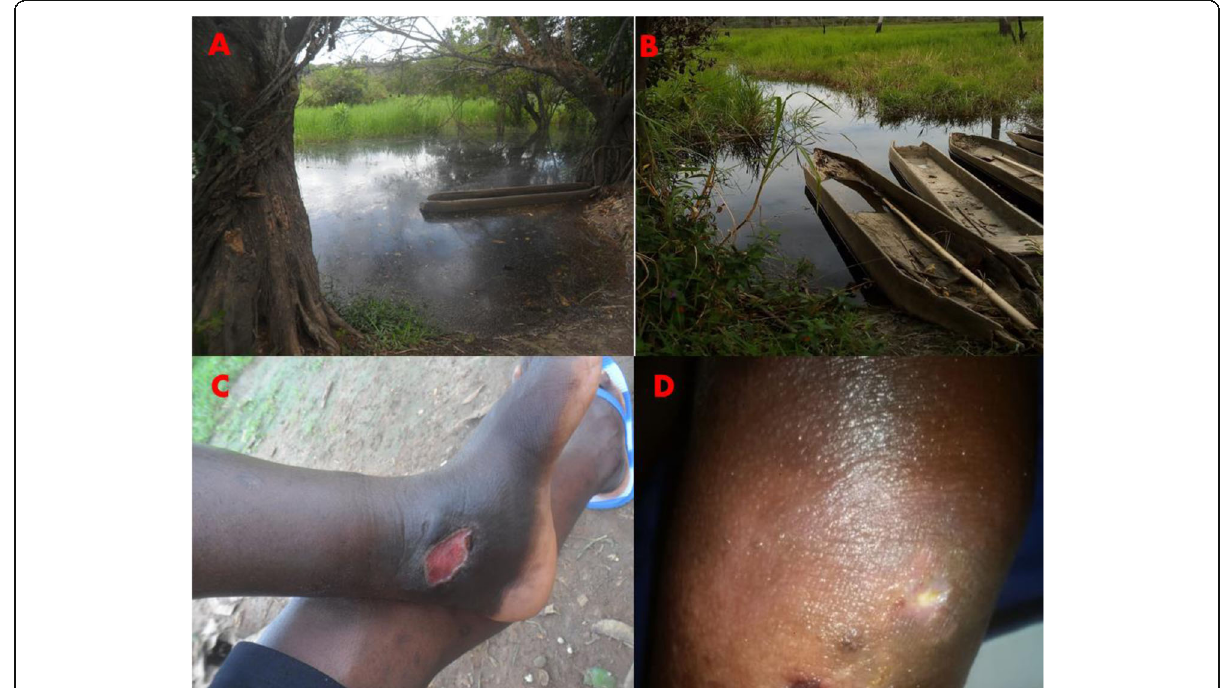
Fig. 1 Two water bodies and two suspected BU-like lesions that were sampled at Edjom. a Nyong river (Nlong). b Fishing activities on the Nyong river. c Suspected BU-lesion (a circular ulcer of the left foot at the granulation phase on an articulation. This is a venous ulcer with a dark background and edema of the foot, found in a 27-year-old fisher. d Suspected BU-lesion (a plate of the left elbow with the onset of ulceration and a fibrinous background, found in a 14-year-old boy). These patients declared to work in close contact with the Nyong river for fishing